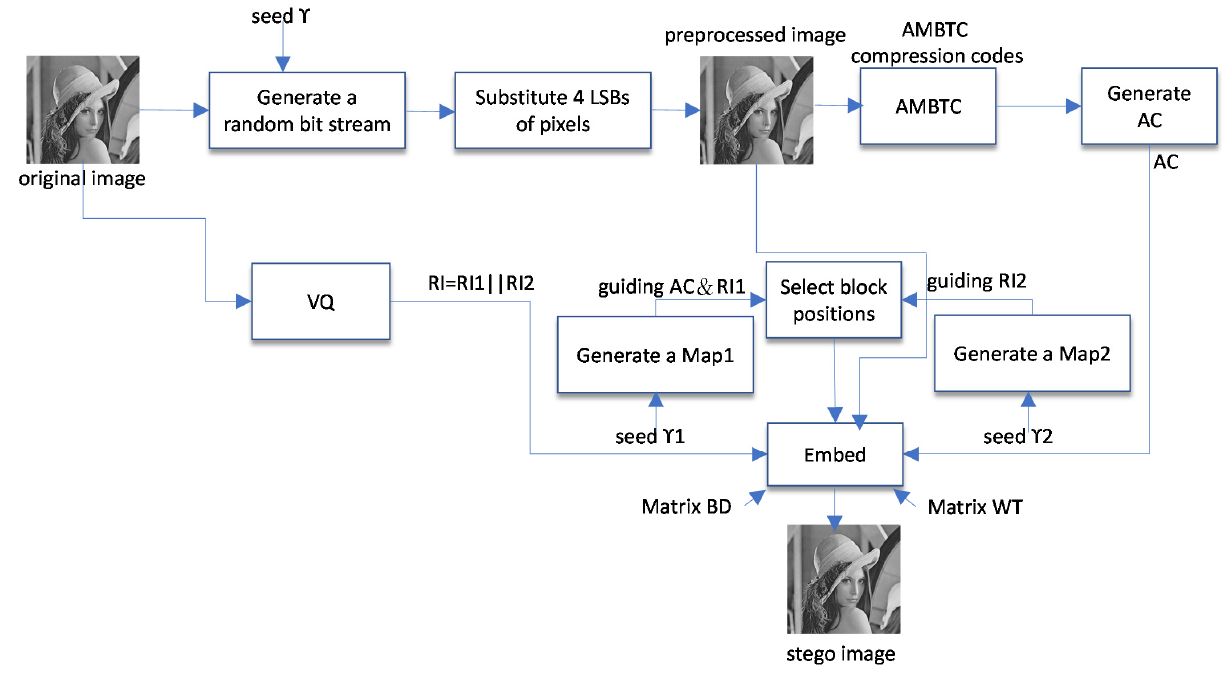
Figure 3. Watermark generation and embedding process.